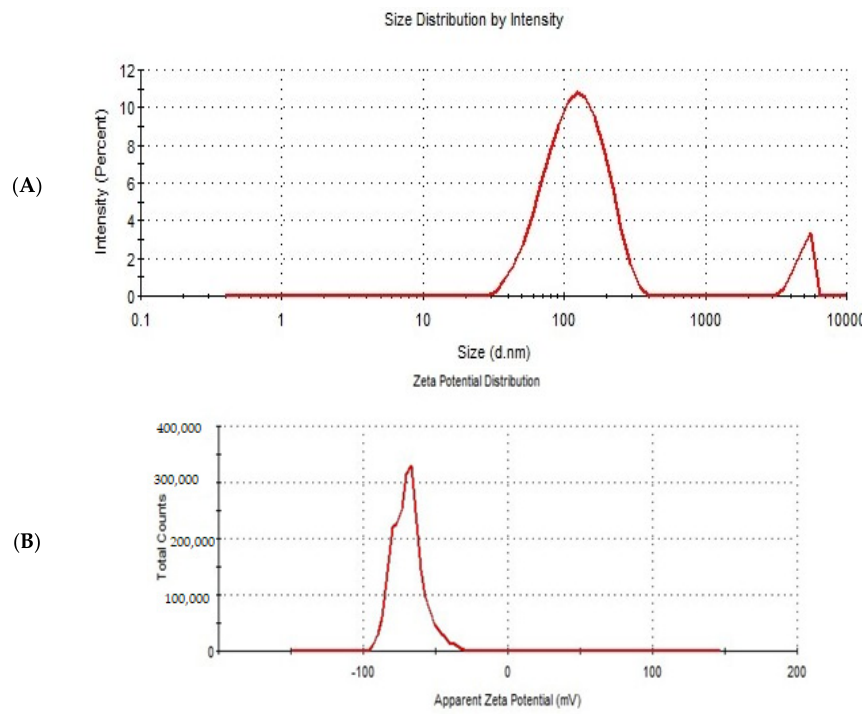
Figure 6. The particle size distribution curve ( A ) and zeta potential ( B ) of the optimized ITZ-TFS4